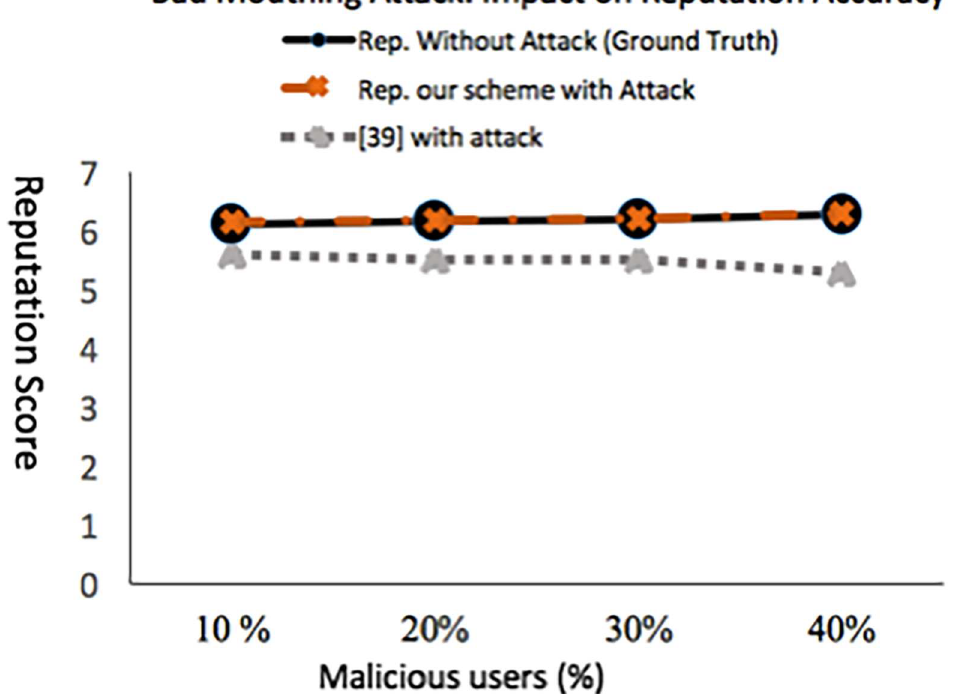
Fig 8. Impact of bad mouthing attack on the accuracy of reputation score when attack is done in t r .